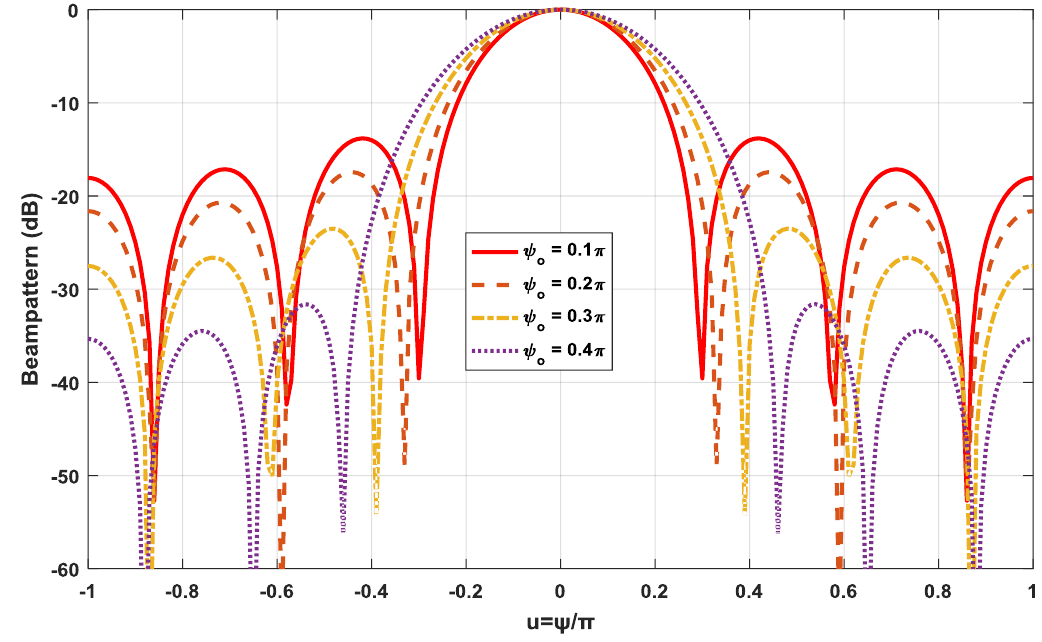
Figure 5. Beam patterns as a function of 𝝍 𝟎 = 𝟎. 𝟏𝝅,𝟎. 𝟐𝝅, 𝟎. 𝟑𝝅, 𝟎. 𝝅𝟒 : Discrete Prolate Spheroidal Sequences (DPSS) weighting,